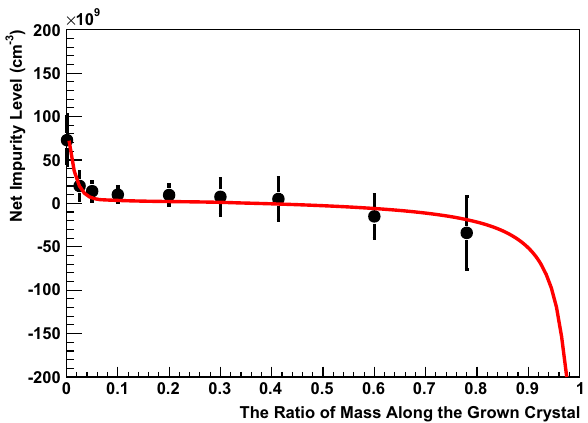
Fig. 4 Shown is a comparison between the experimental data (dotted points in black) and theoretical prediction (Eq. 10, solid line in red) for a grown crystal with large portion to be detector-grade crystal. Note that the ratio of the mass along the grown crystal shown in the x-axis is unitless